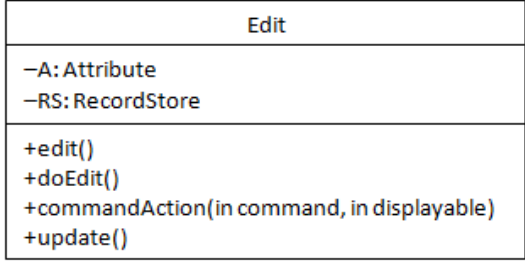
Figure 2. One-function structure for Edit [40].